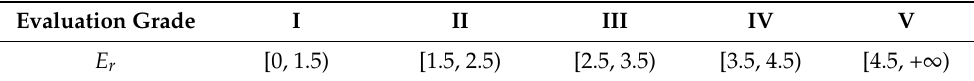
Table 4. Evaluation Grade. Evaluation